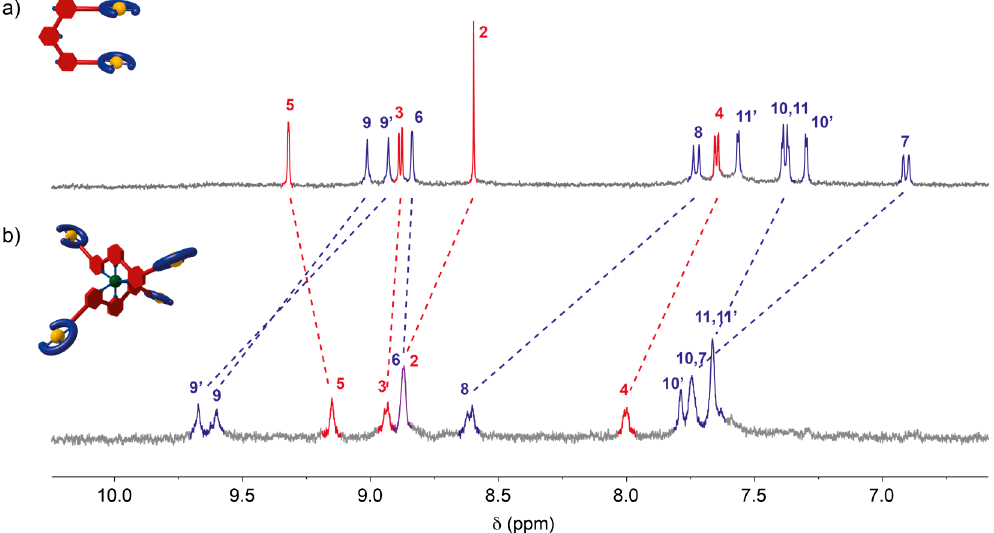
Figure 5. 1 H NMR spectra (400 MHz, 300 K) in DMSO-d 6 of: ( a ) tweezers 1 and ( b ) [Zn( 1 ) 2 ]Cl 2 .